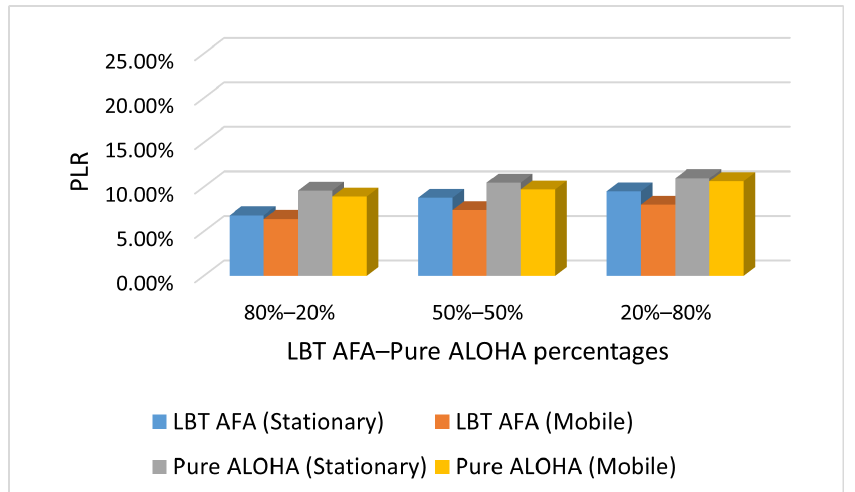
Figure 5. Case M: PLR with varying percentages of end-devices that use Pure ALOHA and LBT